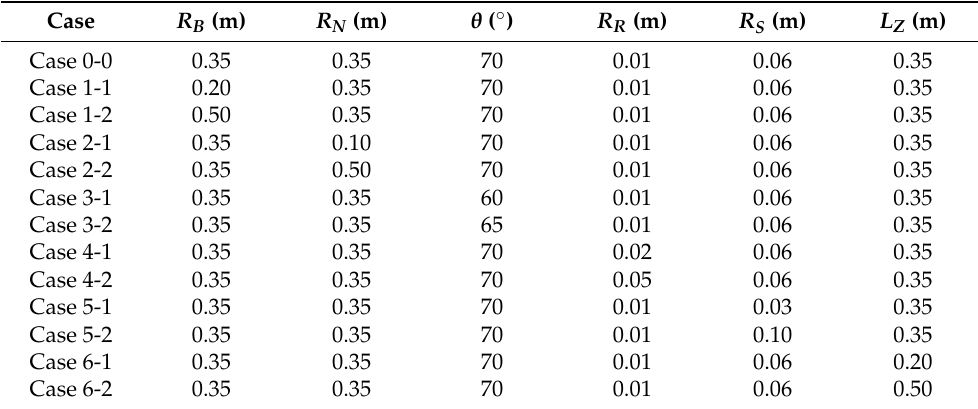
Table 4. Calculation cases of structural parameters